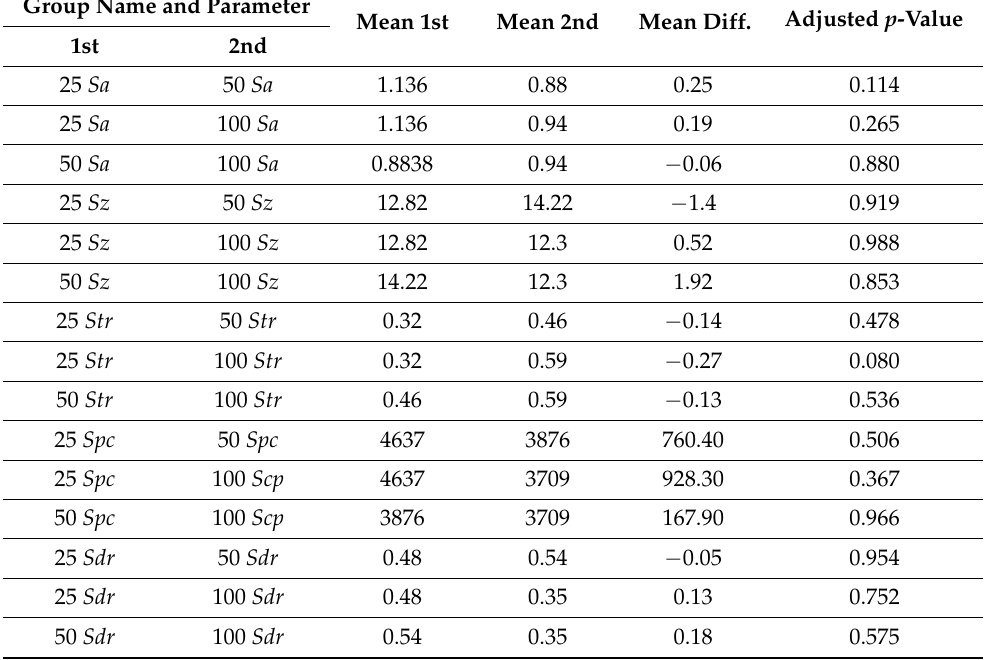
Table 4. Surface roughness comparison among the three groups (25, 50, 100 µ m) using one-way ANOVA and Tukey’s post